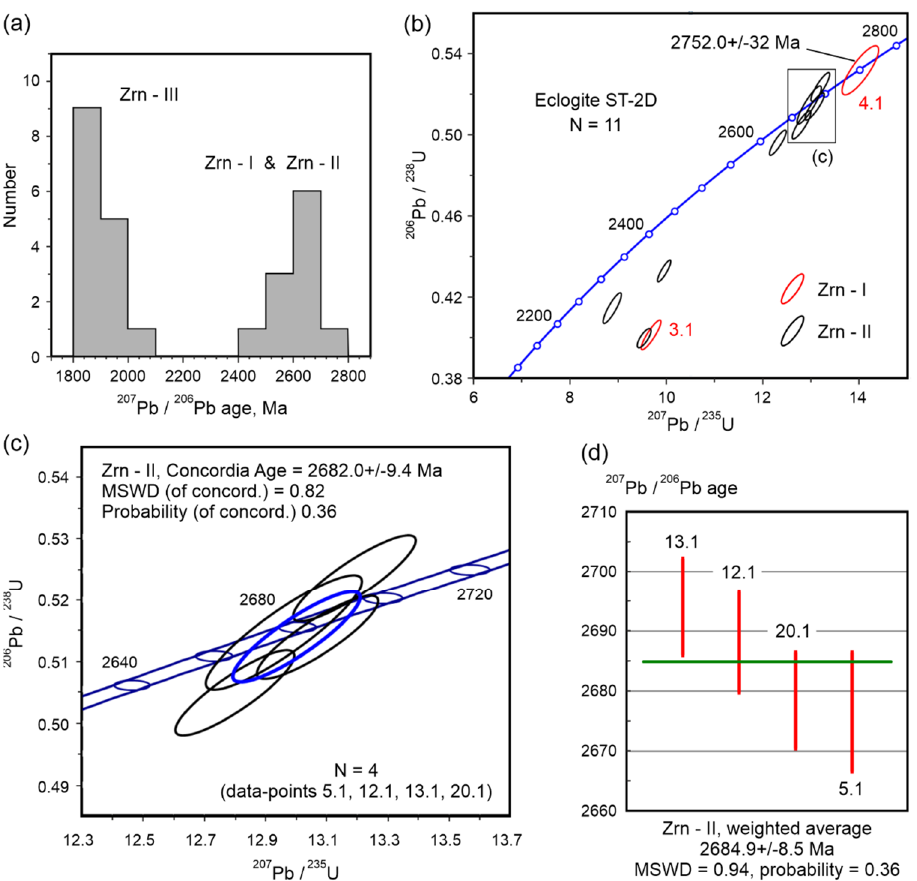
Figure 5. ( a ) Histogram, ( b , c ) concordia diagrams, and ( d ) weighted average 207 Pb/ 206 Pb age plot for zircons from eclogite ST-2D; data-point error ellipses and symbols are 68.3 % and 1 σ confidence, respectively.